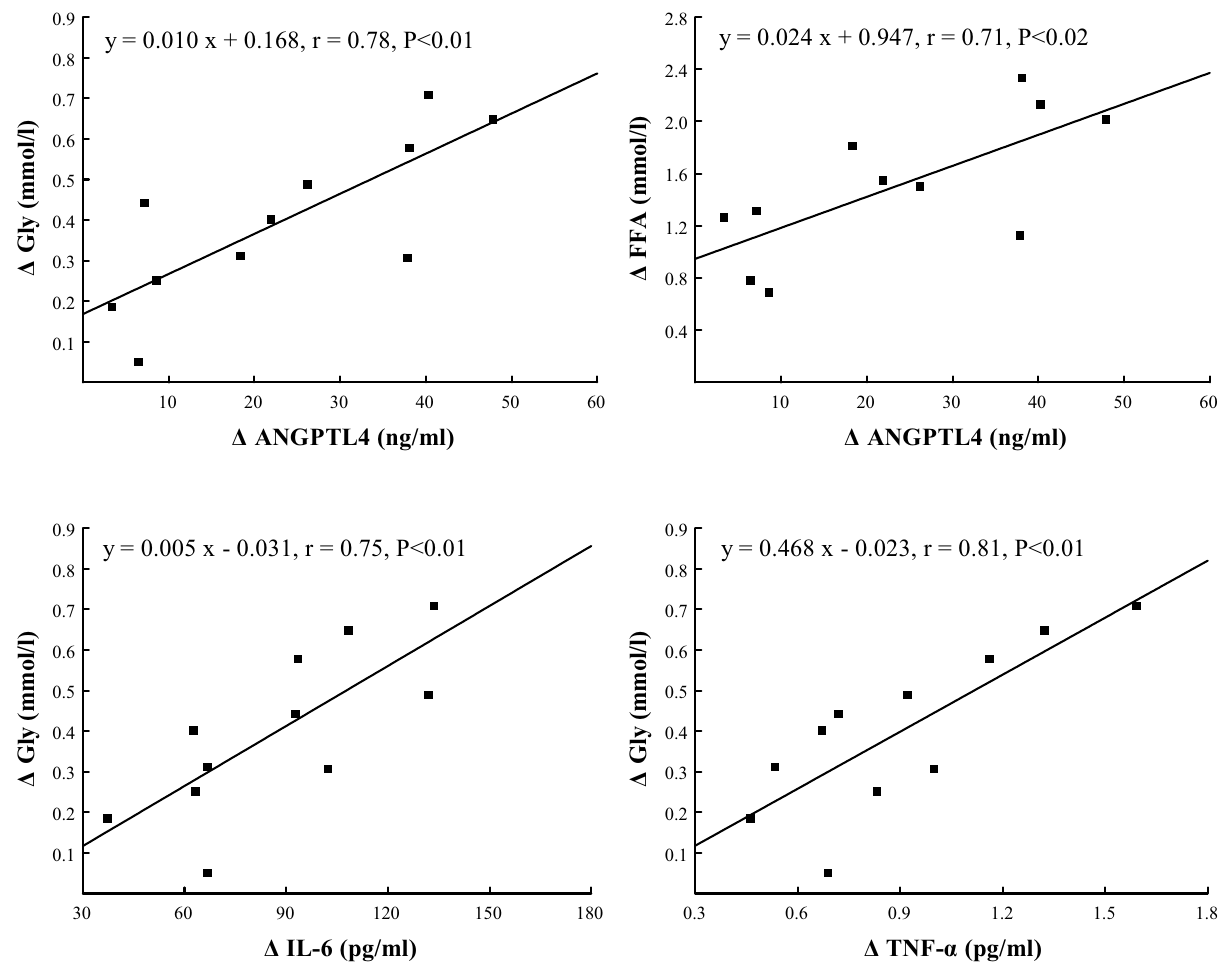
Figure 4. The relationships between exercise-induced changes in plasma concentration of free fatty acids (FFA), glycerol (Gly) and those of plasma angiopoietin-like protein 4 (ANGPTL4), interleukin 6 (IL-6) and tumor necrosis factor-α